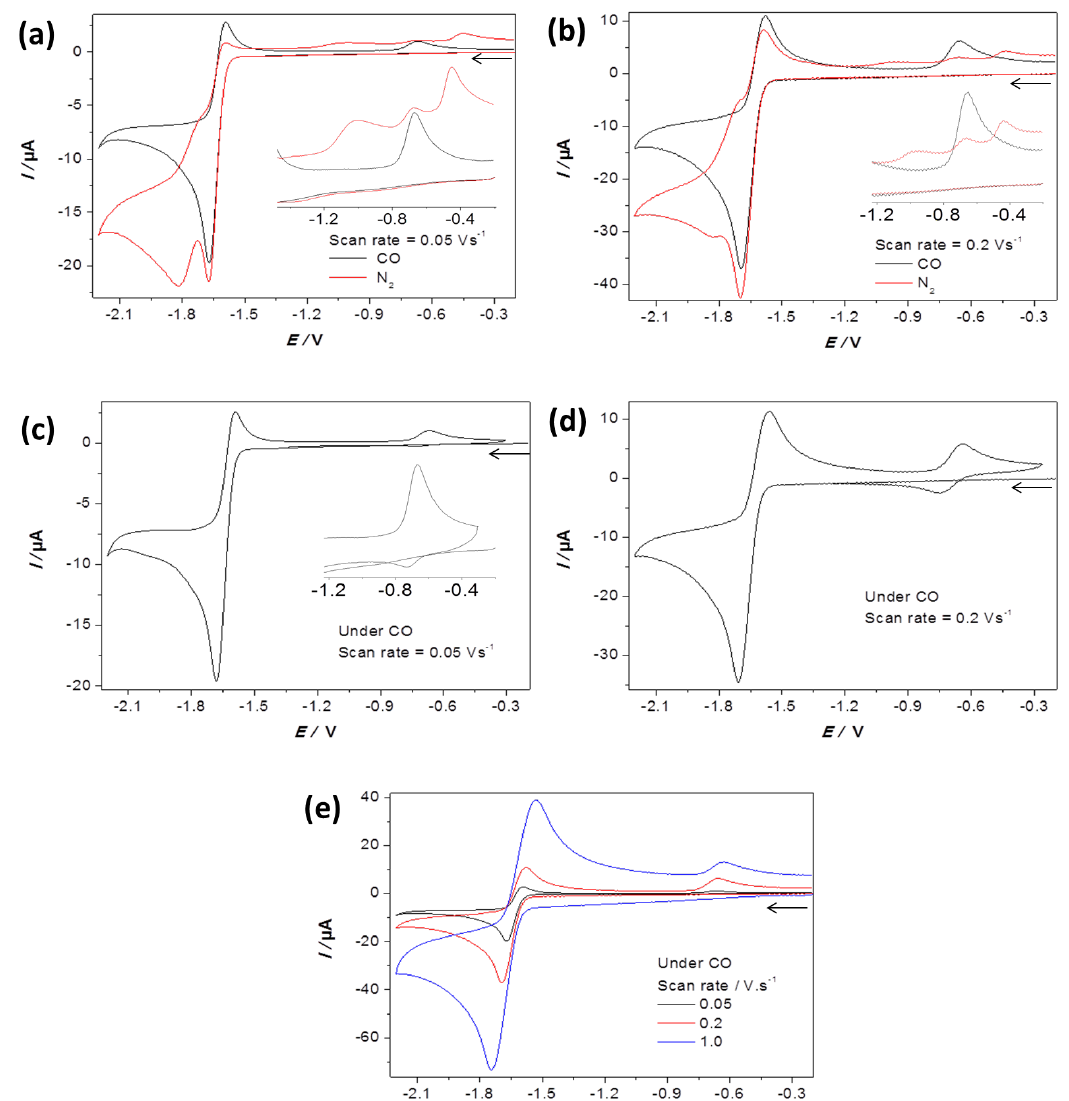
Figure 2. Cyclic voltammetry of 0.843 mM complex 1 in CH 2 Cl 2 /NBu 4 PF 6 under conditions shown in the inset of each panels ( a – e ). Part of the voltammograms ( a – c ) are enlarged and shown in the inset for clarification. Glassy carbon electrode (diameter = 3 mm). Potential, E , is in volt (V) against the ferrocenium/ferrocene couple. The arrows indicate the scan direction.